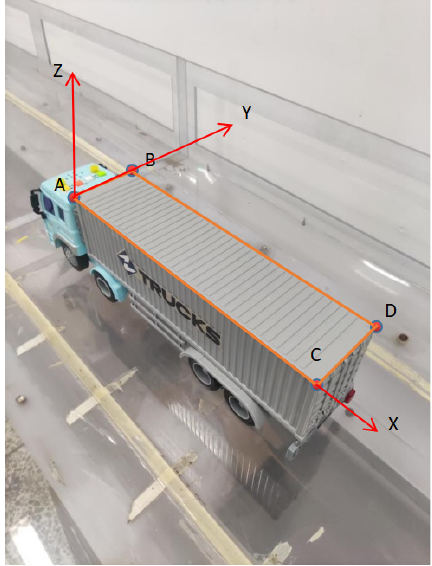
Figure 8. The selected four points and world coordinate system on the